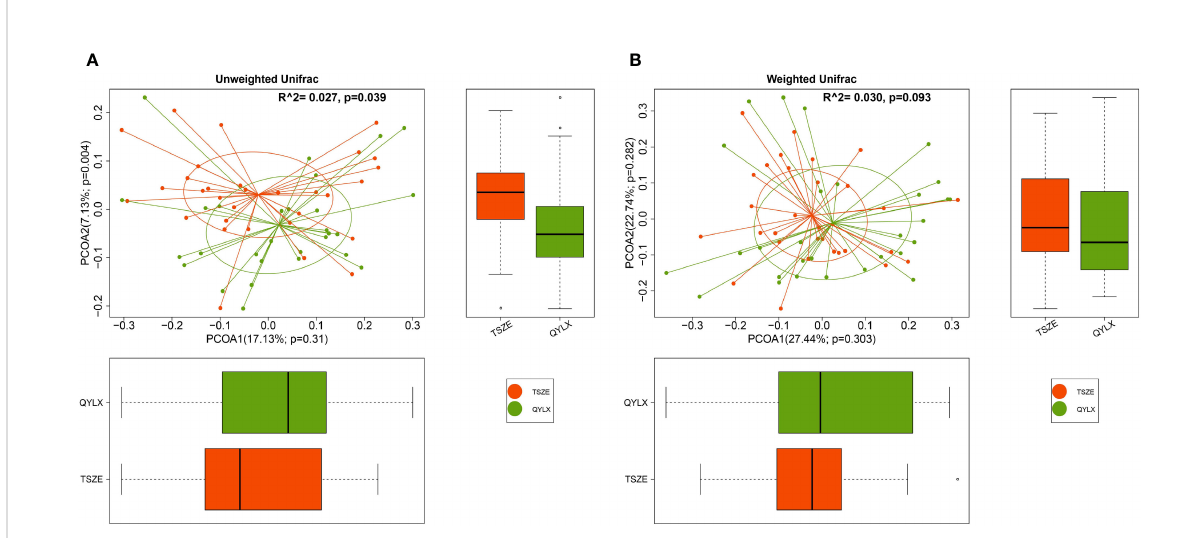
FIGURE 2 Principal coordinate analysis (PCoA) comparing microbiota beta diversity between the QYLX and TSZE groups. Genus-level abundance data are used for calculating both (A) unweighted and (B) weighted UniFrac distances. The horizontal and vertical box plots show the sample distribution on the fi rst and second principal coordinates for each group, respectively. Statistical comparison of microbial communities and each principal coordinate between two groups were based on PERMANOVA and Wilcoxon rank sum test, respectively. P value < 0.05 is considered statistical signi fi cance. QYLX, qi-yin de fi ciency syndrome; TSZE, phlegm-dampness